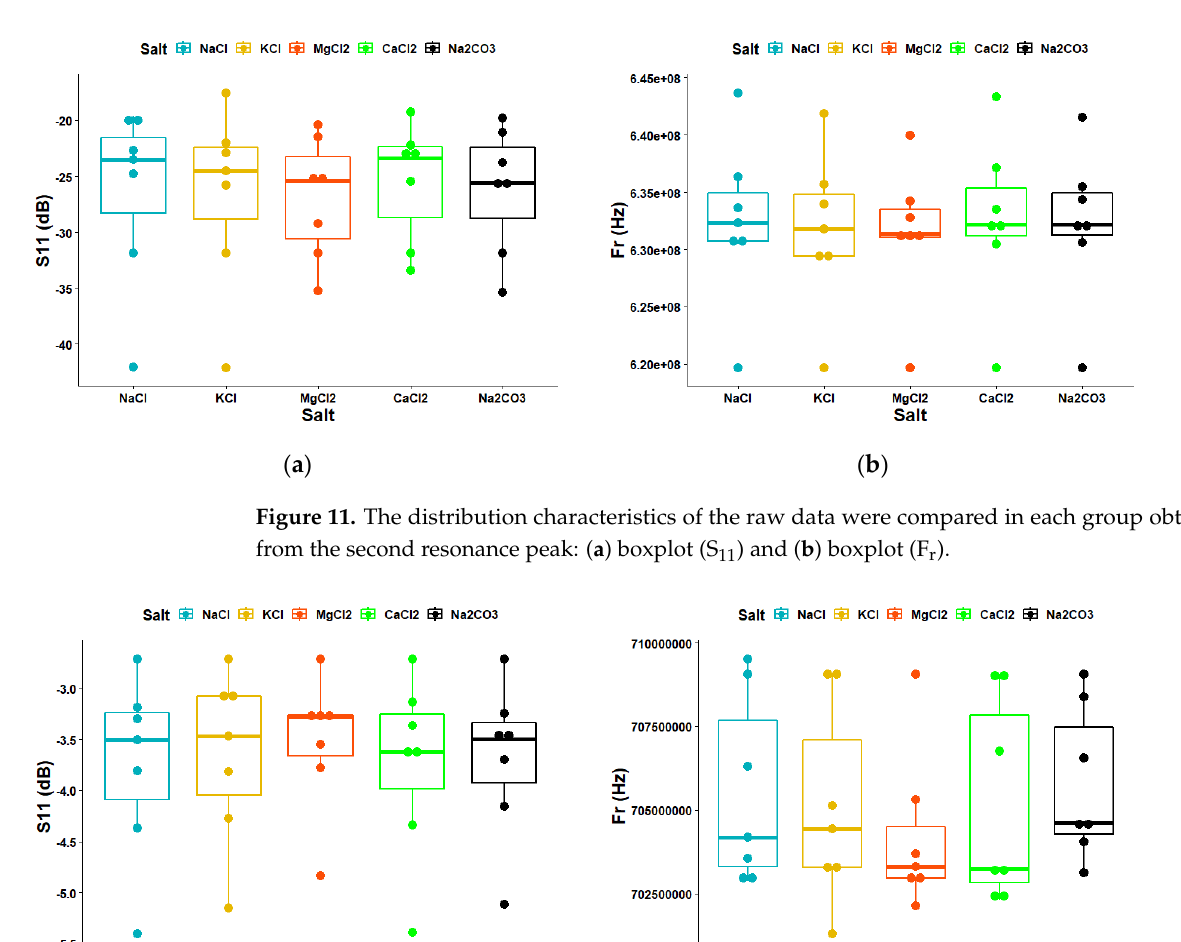
be 0.6338 GHz and 0.6326 GHz, respectively.